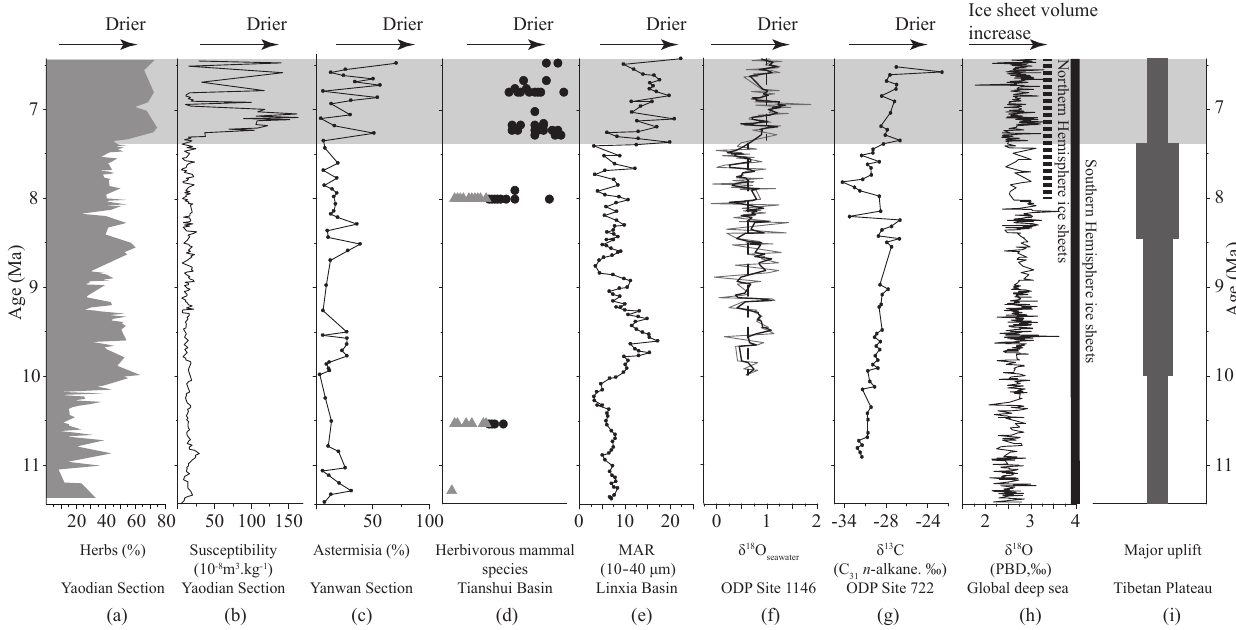
Figure 4. Proxy records of aridification for East Asia during the late Miocene. (a) Herbaceous pollen percentage for the Yaodian Section (this study). (b) The magnetic susceptibility of the Yaodian Section (Zhang, 2013). (c) Drought-tolerant Artemisia pollen percentage in the Yanwan Section, northern Tianshui Basin (Hui et al., 2011). (d) Herbivorous mammal species in the Tianshui Basin (Guo et al., 2002; L. P. Liu et al., 2011; Li et al., 2006; Zhang et al., 2013). Black circles represent species which adapted to relatively arid environments, in- cluding Sinocricetus zdanskyi , Kowalskia sp., Hansdebmijnia pusillus , Lophocricetus grabaui , Mesosiphneus praetingi , M . sp., Paralactaga anderssoni , Parasoriculus sp., Prosiphneus eriksoni , P . licenti , P . tianzuensis , Prospermophilus orientalis , Pseudomeriones abbreuuuus , P . complicidens , Sicista sp., Alilepus annectens , Allorattus sp., Apodemus sp., Chardina sp., C . sinensis , C . truncatus , Chardinomys nihowani- cus , C . sp., C . yusheensis , Pliosiphneus lyratus , Cricetinus mesolophidus , Mimomys teilhardi , Sinotamias sp., Ochotona gracilis , O . lagreli , O . lingtaica , O . minor , O . plicodenta , O. sp., Ochotonoma sp., O . primitiva , Trischizolagus mirificus , Hipparion chiai , H . dermatorhinum , H . fossatum , H . plocodus , H . sp., H . weihoense , and Gazella sp.; grey triangles represent species which adapted to relatively humid environ- ments, including Chleuastochoerus stehlini , Cervavitus novorossiae , Cervidae gen. et sp. indet., Palaeotragus microdon , P . sp., Samotherium sinense , S . sp., Rhinocerotidae indet., Acerorhinus fuguebsis , Chilotherium habereri , C . sp., C . wimani and Protanancus tobieni . (e) Eolian sediment mass accumulation rates in the Linxia Basin, northeastern TP (Fan et al., 2006). (f) South China Sea δ 18 O seawater estimate from ODP Site 1146 (Steinke et al., 2010). (g) Carbon isotope ratios of leaf wax C 31 n -alkane extract from ODP Site 722 (Huang et al., 2007). (h) Compiled global deep-sea δ 18 O values (Zachos et al., 2001, data available online at http://www.es.ucsc.edu/~jzachos/Publications.html; a new compilation has been published by Mudelsee et al., 2014, which is congruent with the Zachos’ curve for the Miocene part). (i) Schematic model showing the major periods of TP uplift (Enkelmann et al., 2006; Fang et al., 2003, 2005; Lease et al., 2007; Li et al., 2014; Molnar et al., 2010; Wang et al., 2006; X. X. Wang et al., 2012; Zheng et al., 2006,